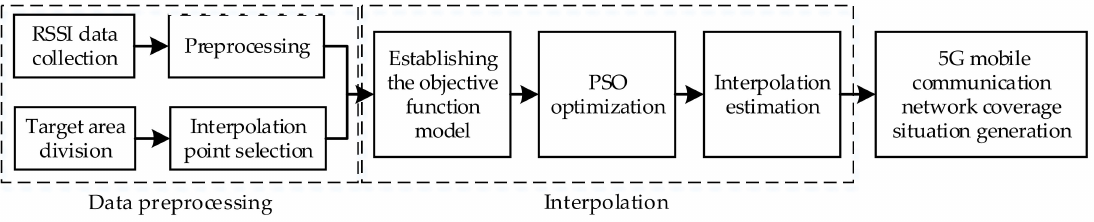
Figure 1. 5G mobile communication network coverage detection technology